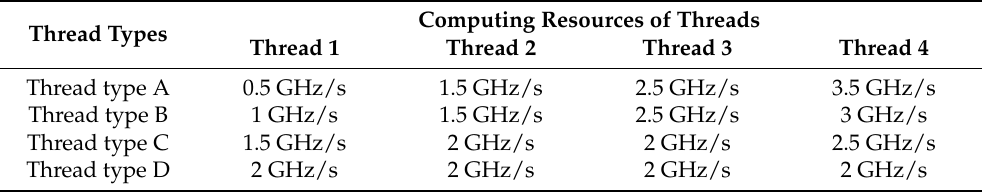
Table 3. The computing resource configuration for the